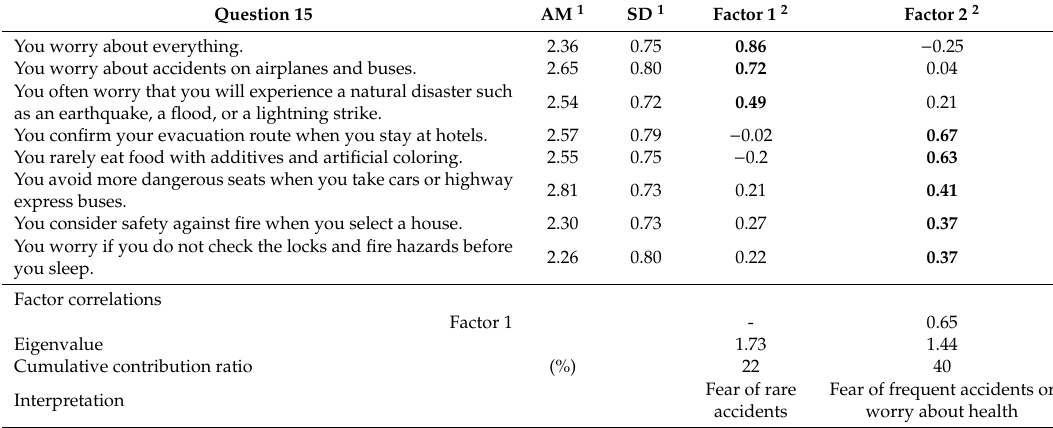
Table 5. Arithmetic mean, standard deviation, and factor loading matrix for risk-avoidance orientation and interpretations of the factors. KMO, 0.81; p < 0.001 (Bartlett’s test).